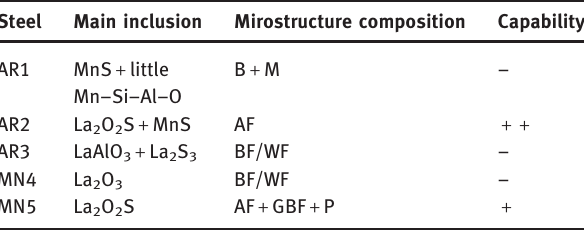
Table 2: Capability comparison of inclusion inducing AF nucleation.